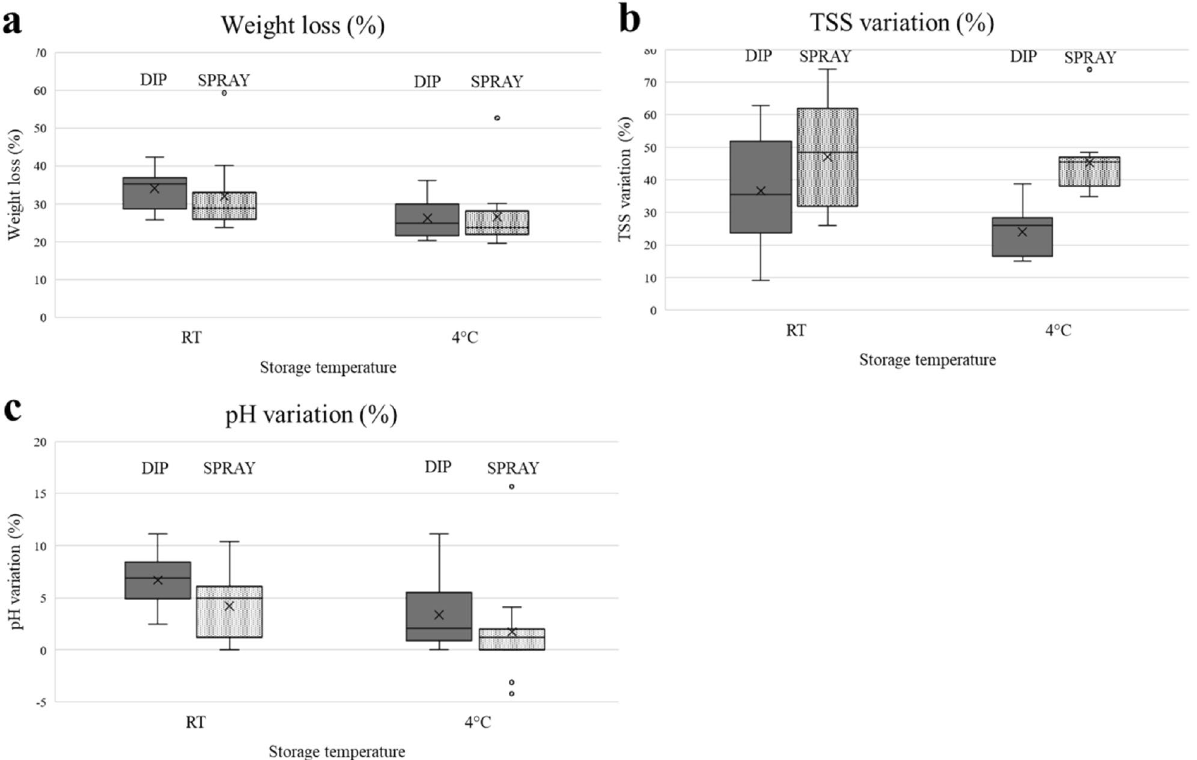
Figure 2. Box plots representing the variation in weight loss ( a ), TSS content ( b ) and pH ( c ) of tomatoes depending on the coating application method (dip or spray).